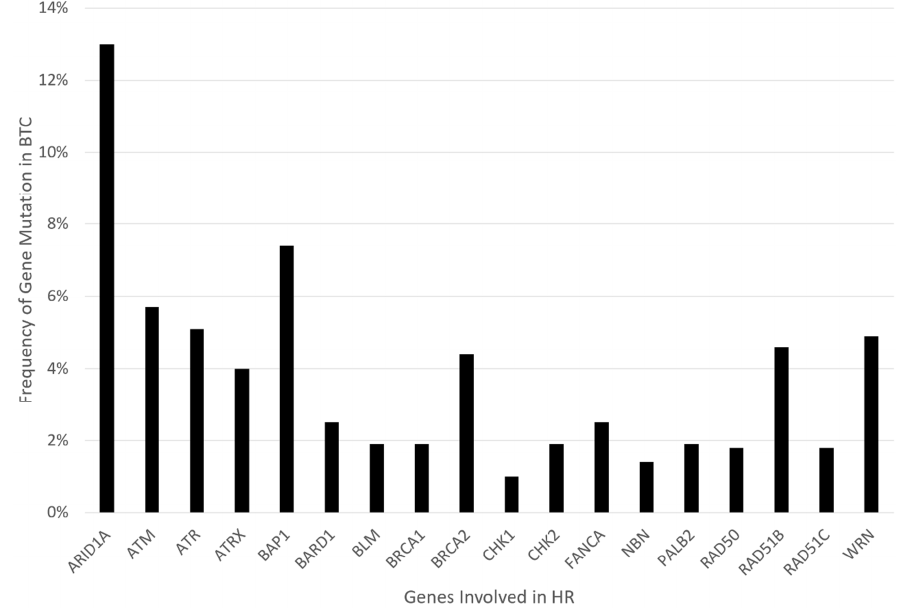
Figure 1. Graphical representation of mutation frequency in genes involved in